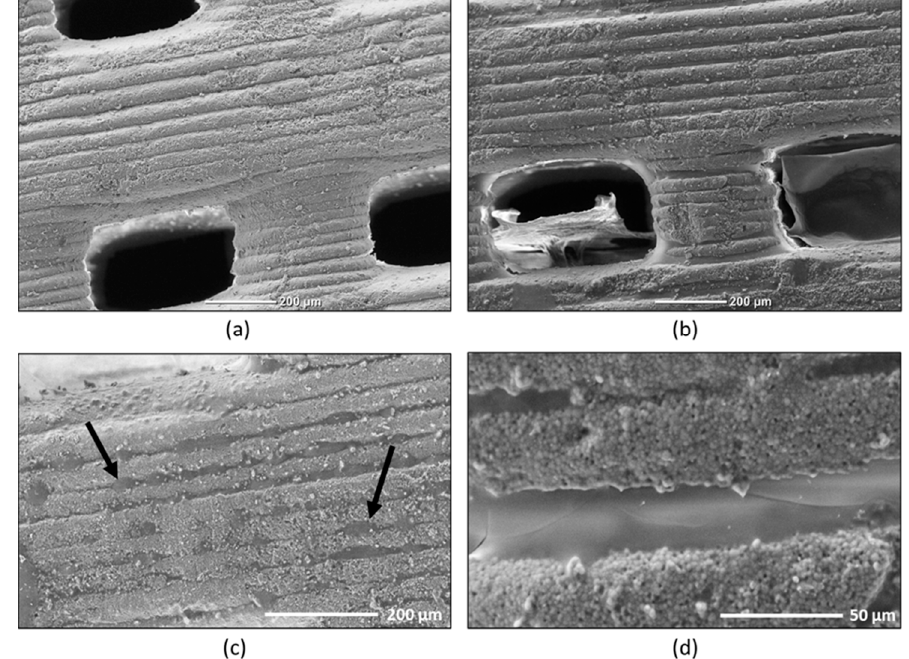
Figure 1. SEM observations of the surface of the alginate-covered pellets. ( a ) Overview micrograph of the control pellets; ( b – d ) micrographs at different scales of the 1% alginate–CaCl 2 -coated pellets.